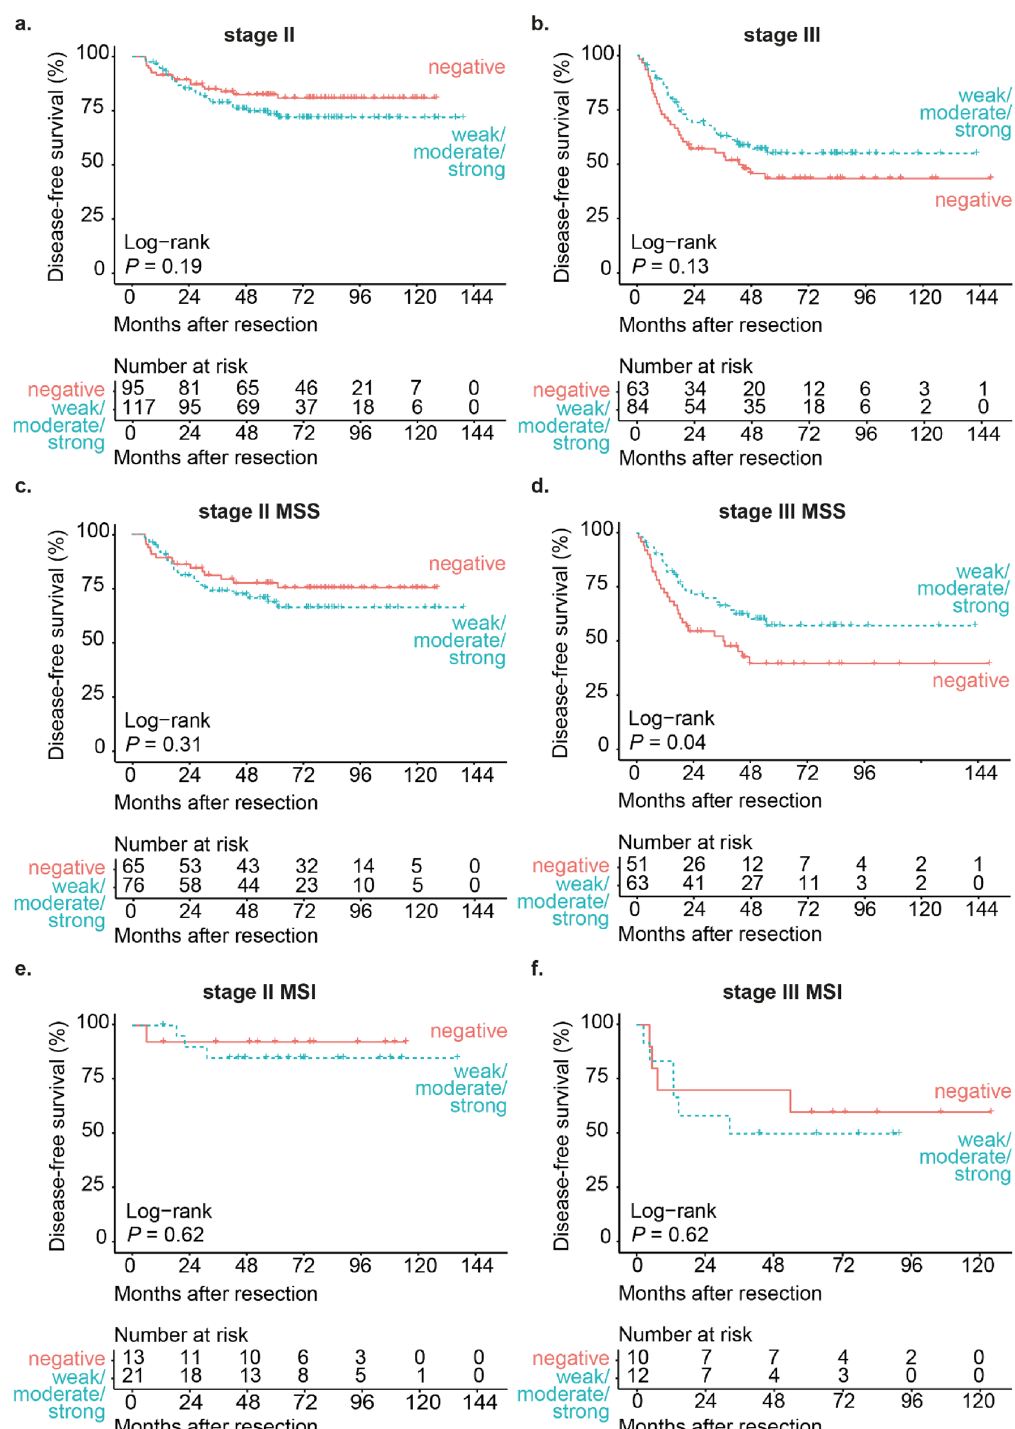
Figure 2. High SLPI expression in stage III MSS CRC is associated with increased disease-free survival. Kaplan–Meier curves for disease-free survival after resection of the primary tumor (in months) for either stage II CRC patients ( a ) or stage III CRC patients ( b ) stratified by SLPI expression detected using the monoclonal antibody. Kaplan–Meier curves for disease-free survival after resection of the primary tumor (in months) for stage II CRC patients with MSS ( c ) or MSI tumors ( e ) and stage III CRC patients with MSS ( d ) or MSI tumors ( f ) stratified by SLPI expression detected using the monoclonal antibody. Curves with the validated cut-off are shown. P -values were calculated using the log-rank test. MSS micro-satellite stable, MSI micro-satellite